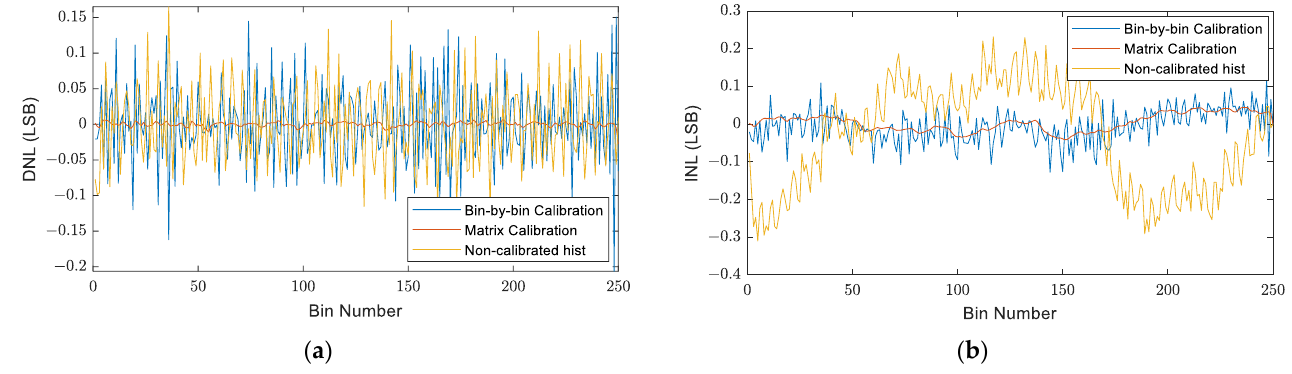
Figure 16. DNL and INL values, for an asynchronous TDC, before and after applying the two calibration methods: ( a ) DNL values; ( b ) INL values. Table 2. DNL and INL statistics for an asynchronous TDC calculated for the non-calibrated histogram and the calibrated histograms of the two methods.